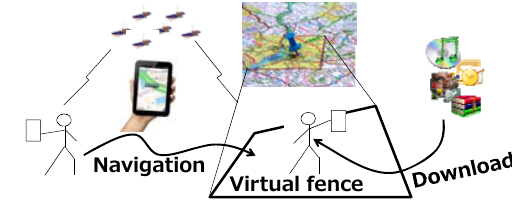
Figure 1. Geofencing